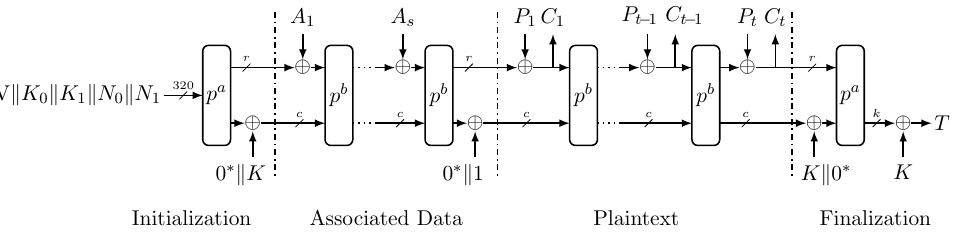
Figure 2: The encryption algorithm of Ascon